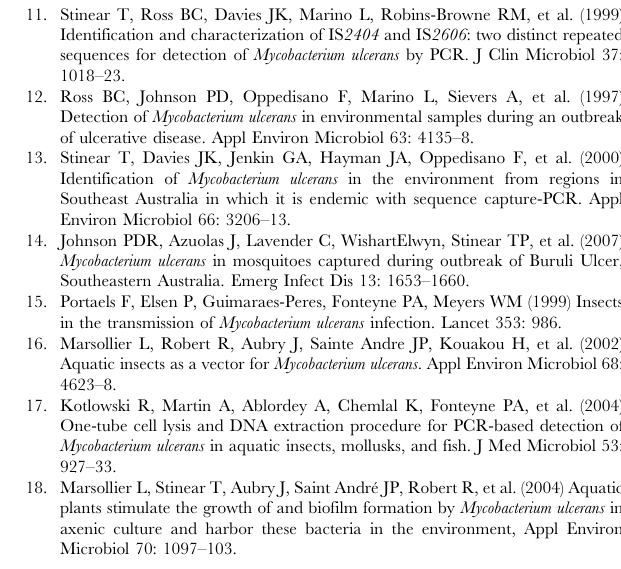
Figure S2 ER PCR and VNTR profiling of belostomatid samples spiked with dilutions of M. ulcerans . A. ER PCR of belostomatid samples spiked with serial dilutions of M. ulcerans 1615. B–E. VNTR analysis of MIRU 1 (B), Locus 6 (C), ST1 (D), and Locus 19 (E) of belostomatid samples spiked with serial dilutions of M. ulcerans 1615. All lanes are labeled 1: 1KB ladder; 2: water blank DNA extraction; 3: water blank PCR; 4: belostomatid with no M. ulcerans added; 5: belostomatid with predicted 10 5 CFU M. ulcerans 1615; 6: belostomatid with predicted 10 4 CFU M. ulcerans 1615; 7: belostomatid with predicted 10 3 CFU M. ulcerans 1615; 8: belostomatid with predicted 10 2 CFU M. ulcerans 1615; 9: belostomatid with predicted 10 CFU M. ulcerans 1615; 10: belo- stomatid with predicted 1 CFU M. ulcerans 1615; 11: belostomatid with predicted 0.1 CFU M. ulcerans 1615; 12: belostomatid with predicted .01 CFU M. ulcerans 1615; 13: M. ulcerans 1615. Found at: doi:10.1371/journal.pntd.0000205.s002 (0.05 MB JPG) Table S1 Pooled or individual organisms sampled in Ghana 2004–2006 from a particular taxon that were found to be ER PCR negative. 1 Samples in total quantities above five were pooled in sets of 3–15. Denominator represents total number of pooled or individual samples collected from the specific